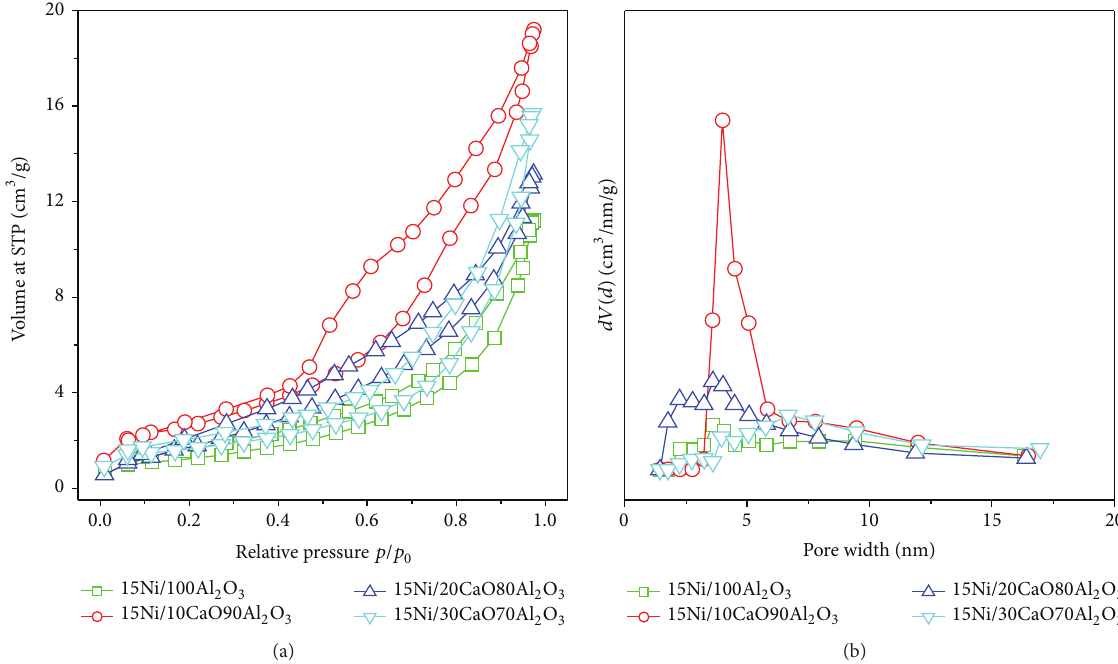
Figure 1: N 2 adsorption/desorption isotherms (77 K) (a) and pore size distributions obtained applying the BJH equation (b) corresponding to the catalysts. Table 1: Textural properties of Ni/CaO-Al 2 O 3 catalysts with different CaO contents. Sample Specific surface area a (m 2